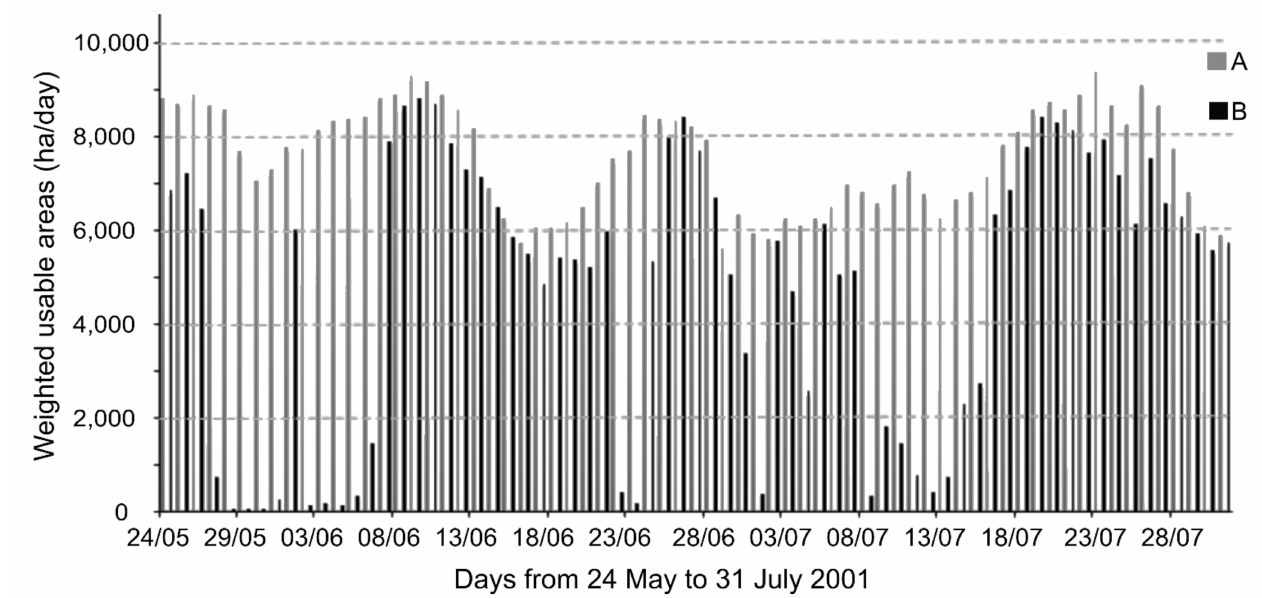
Figure 4. Daily weighted usable areas (WUA ha) between 24 May and 31 July corresponding to carp spawning habitat available in the freshwater river reach between Lake St. Louis and Trois-Rivi è res. Values were computed for two scenarios: (A; medium grey) excluding water temperature and (B; black) including water temperature as simulated for